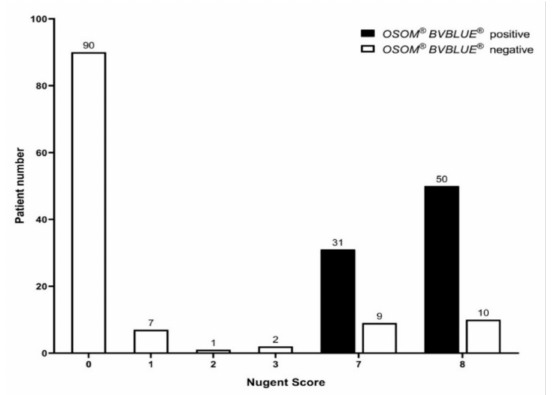
Figure 2. Results of the OSOM ® BVBLUE ® Test according to the Nugent score of 200 asymptomatic pregnant